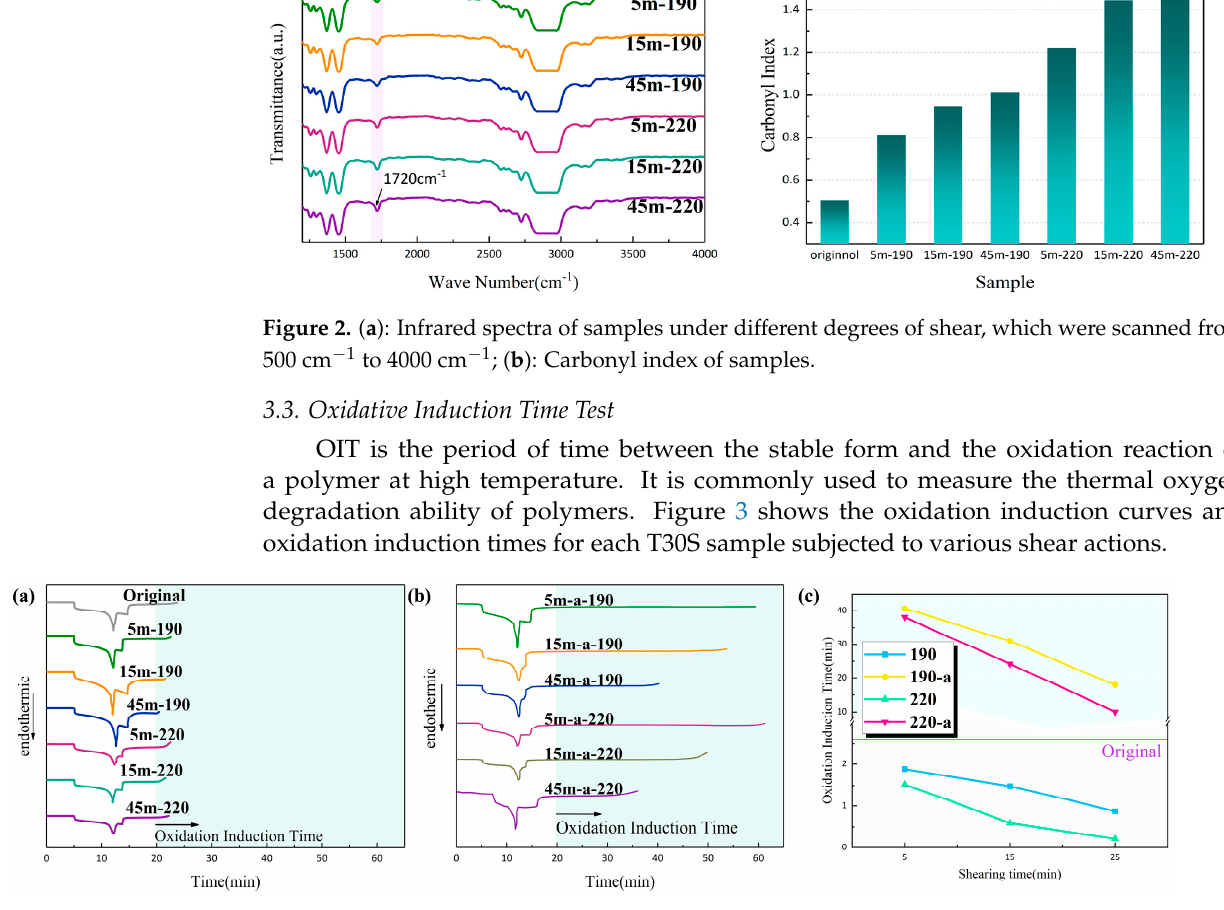
Figure 3. Oxidation induction curves of each sample, which were tested from 18.8 min to 65 min. ( a ): Oxidation induction curves of samples without antioxidant. ( b ): Oxidation induction curves of samples with antioxidant. ( c ): Oxidation induction time of each sample. (The endothermic and arrow indicate the direction of the endothermic peak.)